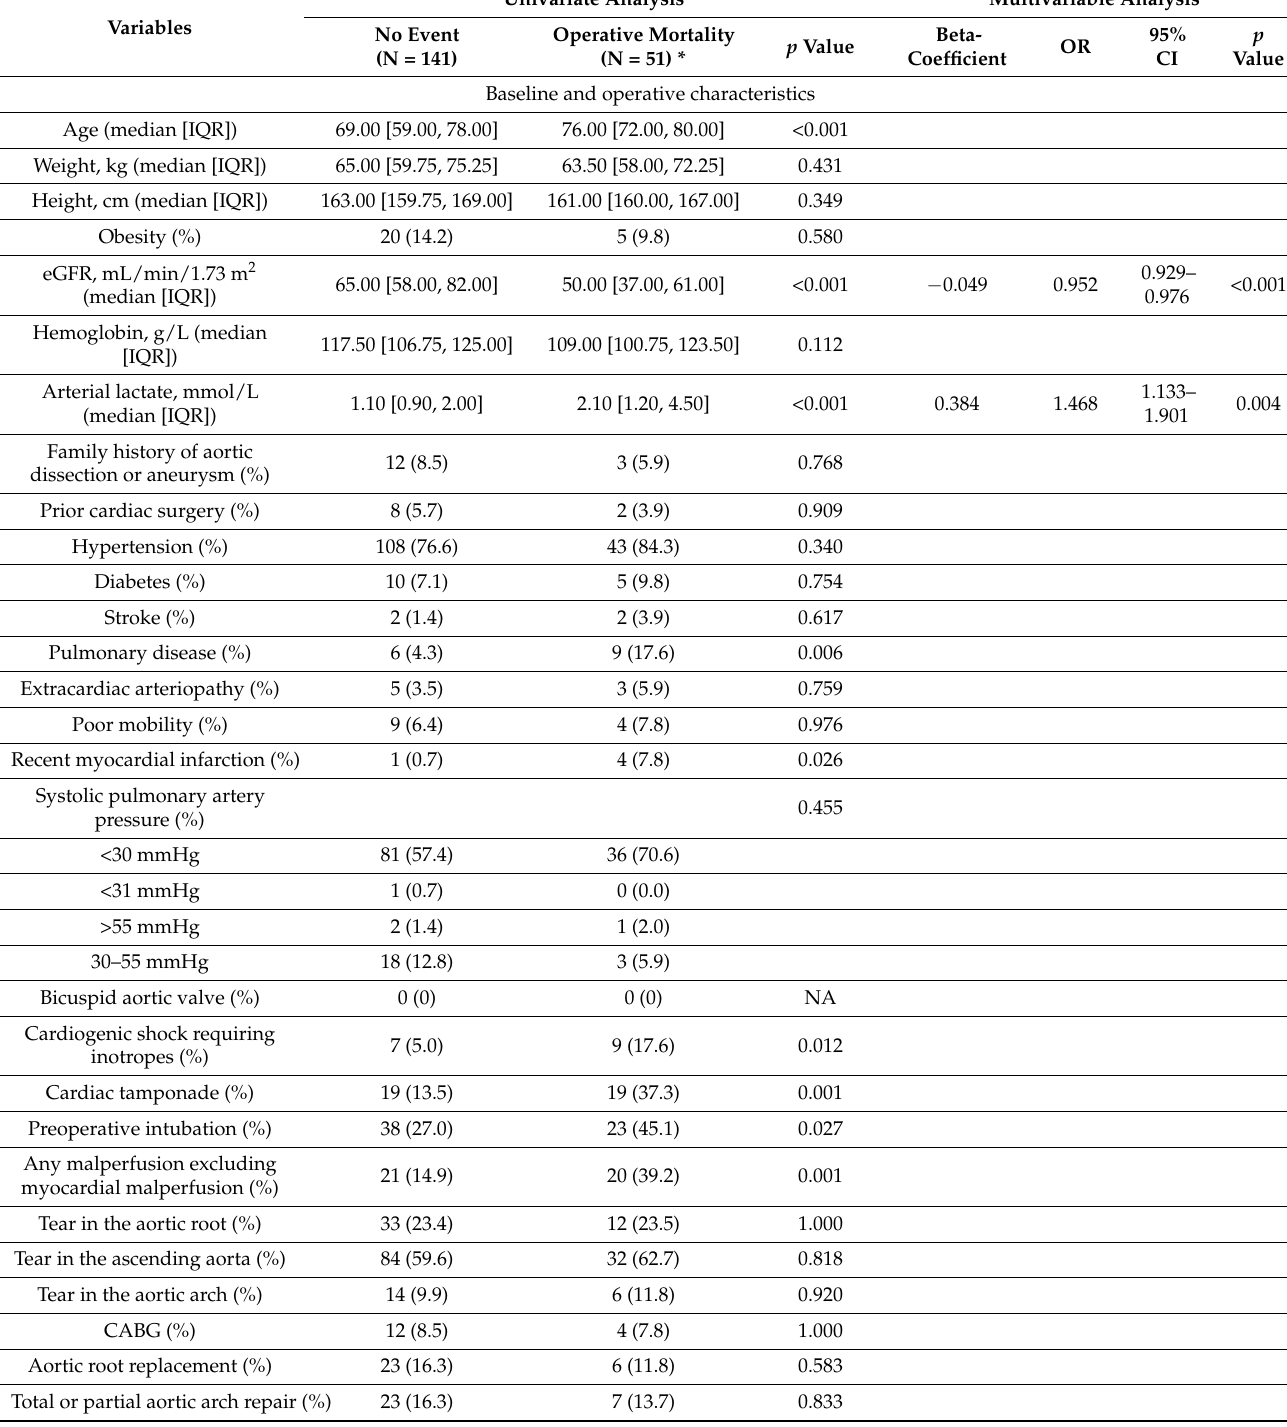
Table 3. Univariate and multivariable analyses for operative mortality of women